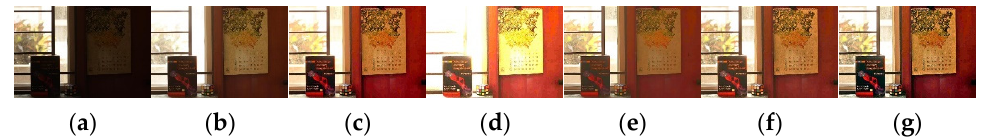
Figure 8. ( a ) Original image; ( b ) Reference. The remaining images are enhancement results, gener- ated by the following methods: ( c ) ALSM, ( d ) Li et al. [26], ( e ) LR3M, ( f ) LIME, and ( g ) the proposed method.